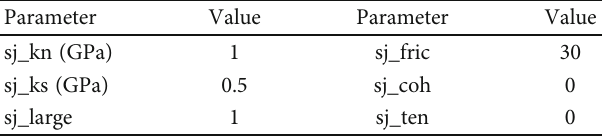
Table 2: Mechanical parameters of the